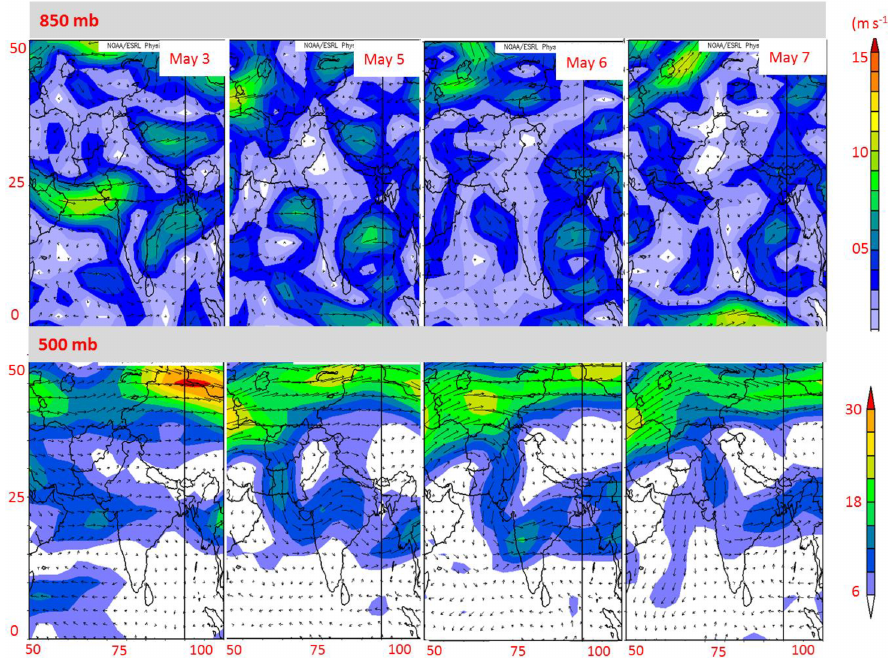
Figure 2. Daily wind vector data at 850 and 500mb, plotted using the NCEP NCAR reanalysis (2.5 ◦ × 2.5 ◦ ) data over southern Asia from 1 to 7 May 2016. The colors indicate the wind speed in ms − 1 . The plots were generated using the default setup at https://www.esrl.noaa.gov/ psd/data/composites/day/ (last access: 4 May 2017).